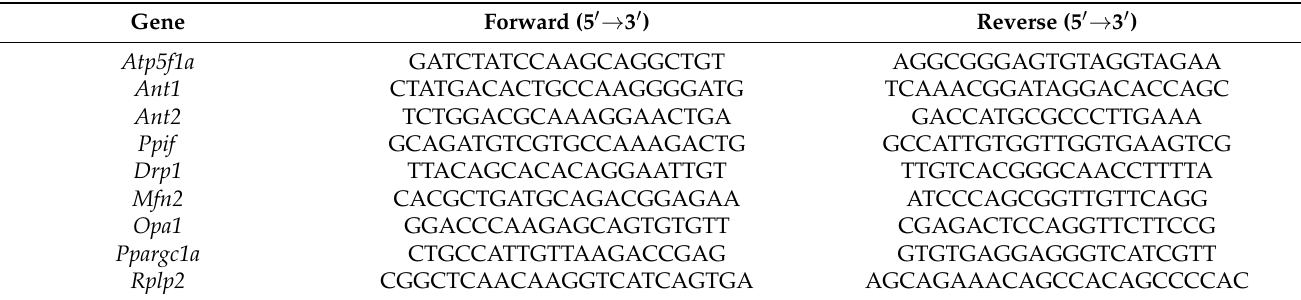
Table 2. List of gene-specific primers for RT-PCR